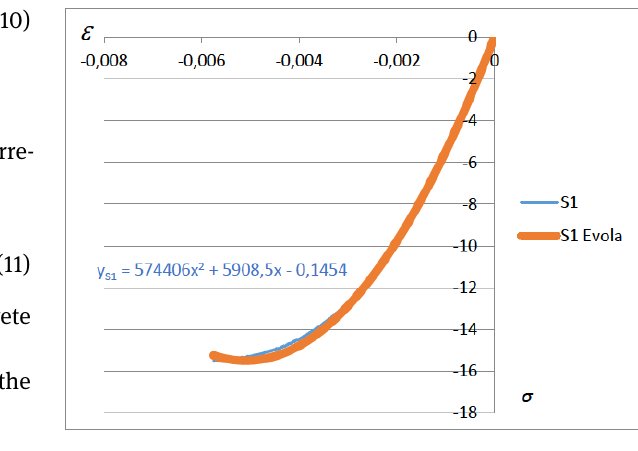
Figure 12: S1 Evola function compared to S1 (from